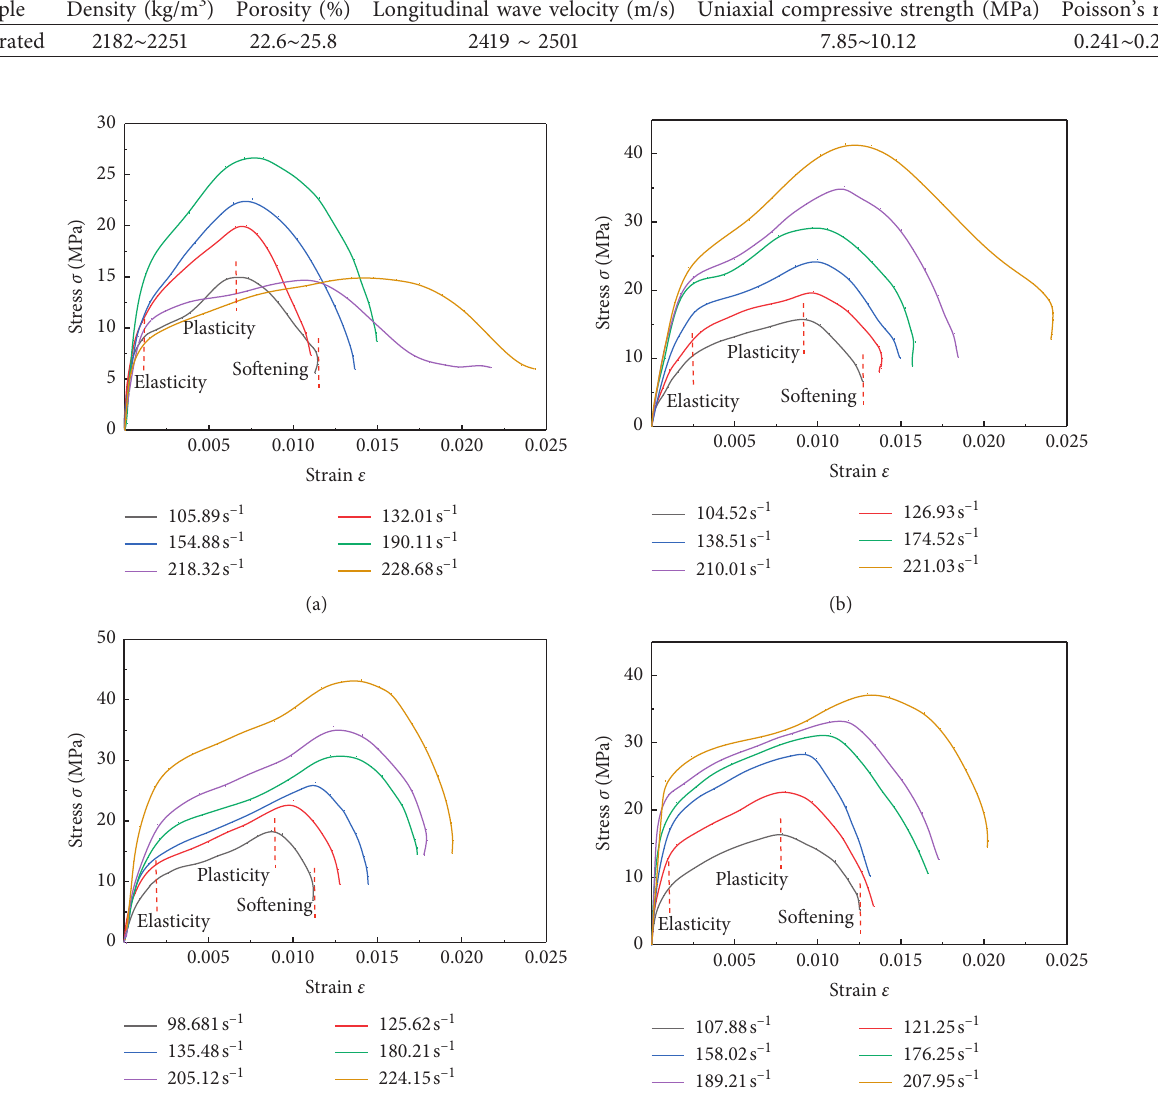
Table 1: Properties of sandstone at room temperature.